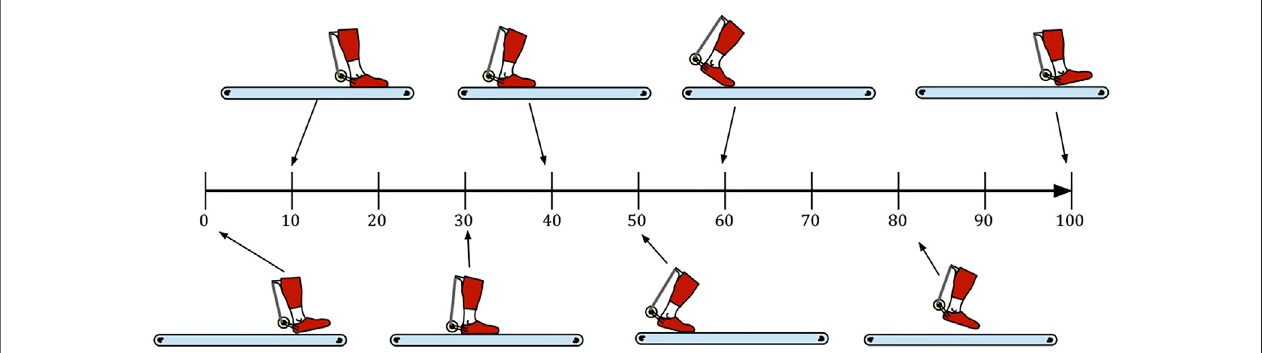
FIGURE5| TimelineofgaiteventsasobservedduringtheACTIVEcondition.Thelegreachesitsmostanteriorpositionat0%ofstride.Analmost fl at-footheelstrike occursaround10%ofstride.Thelegismovedposteriorlybythetreadmill.Shortlyafter50%ofstridetheheelleavesthetreadmill,followedbytoe-offeventshortlybefore 60% of stride. The remaining part of stride consists of the swing phase.